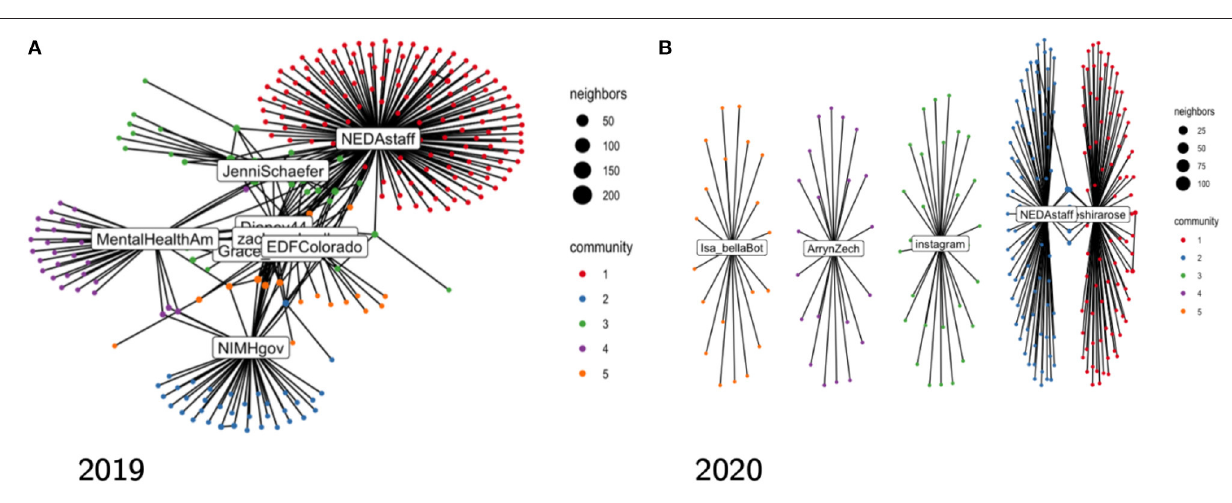
FIGURE 5 | Top 5 communities in the retweet network, as identified using the Walktrap